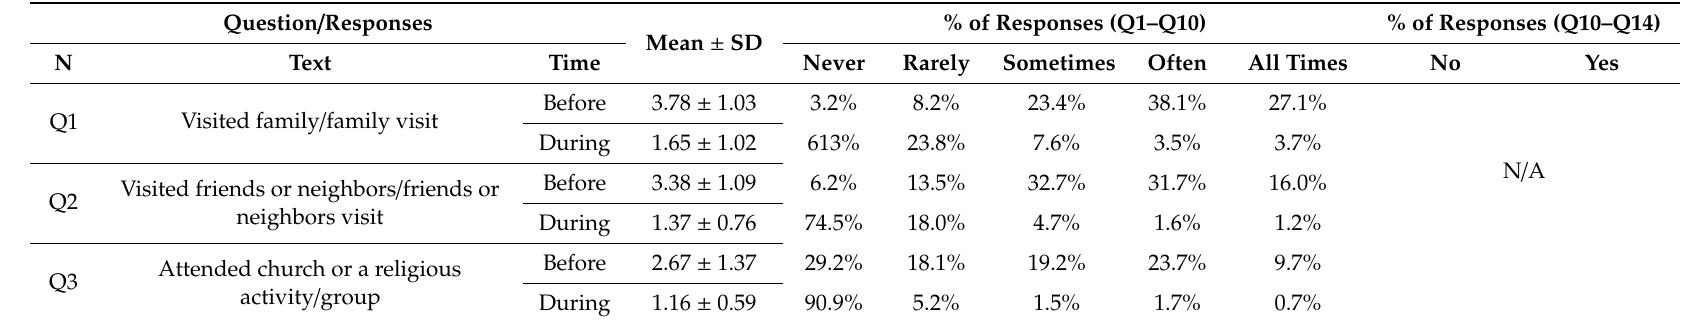
Table 3. Distribution of responses (%) in each item of the social participation